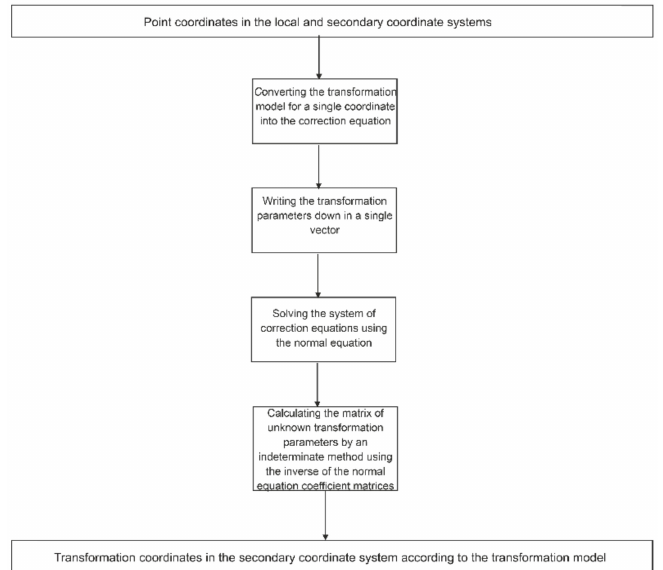
Figure 6. Flowchart showing steps of mathematical model of seven-parameter transformation (Bursa- Wolf transformation) in the matrix